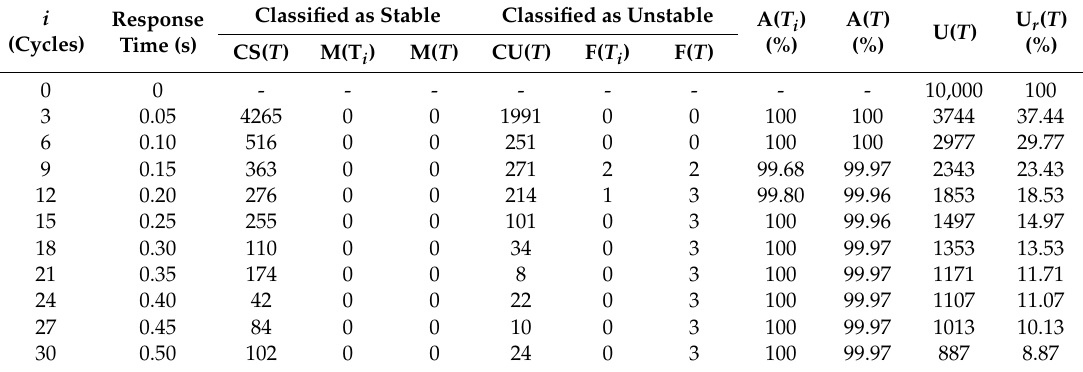
Table 3. Prediction results of the hierarchical self-adaptive method.